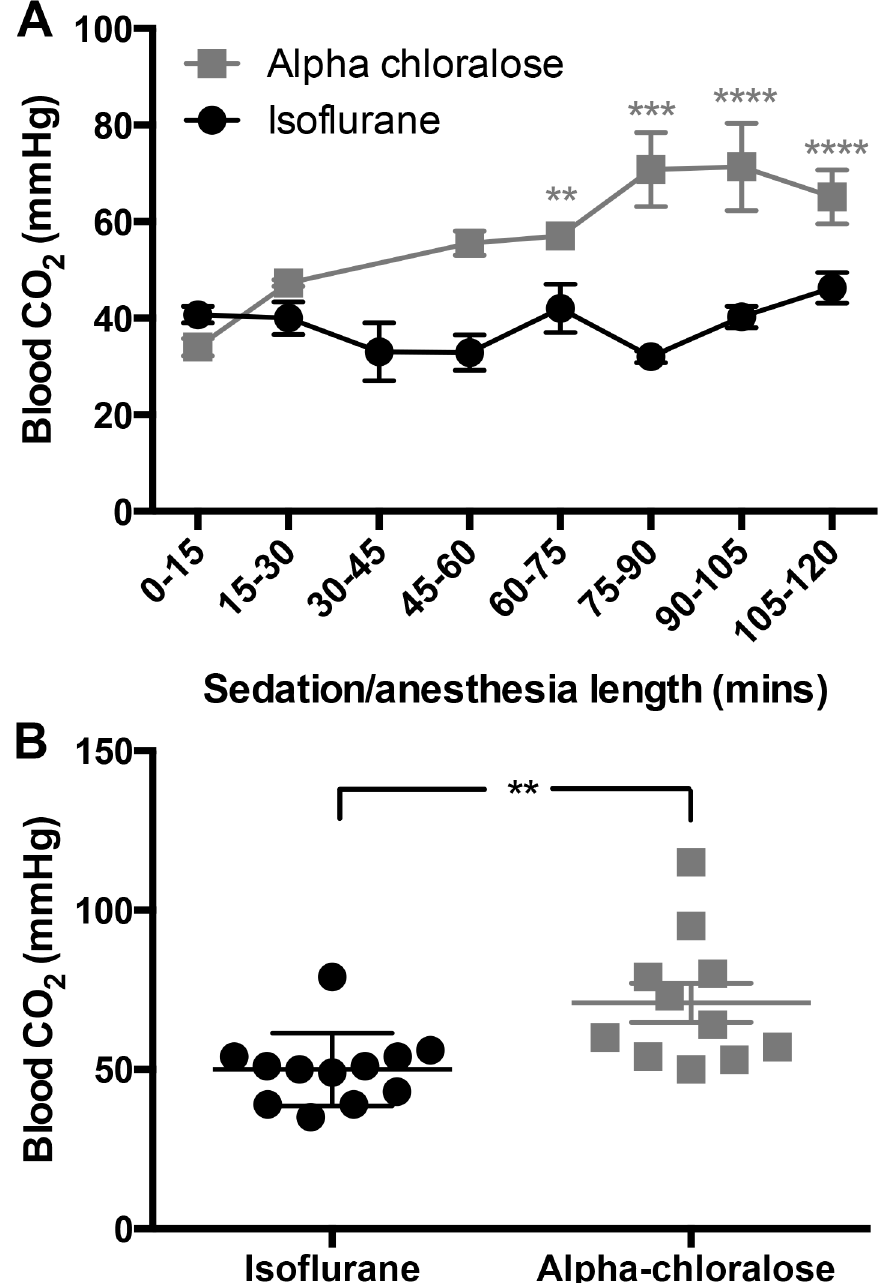
Fig 4. Blood carbon dioxide levels increase significantly under alpha chloralose sedation over the course of 120 minutes. A) Carbon dioxide levels in arterial blood were significantly higher under alpha chloralose sedation (F (1,82) = 38.06, p < 0.0001, n = 4 – 19 per time point). Although there was an overall effect of time (F (5,82) = 4.06, p = 0.002), reflecting increasing CO 2 levels over time, these levels did not differ significantly from baseline over the course of 120 minutes under isoflurane anesthesia (p > 0.05). B) After 120 minutes, carbon dioxide levels are significantly higher in alpha chloralose-sedated animals (p = 0.002).